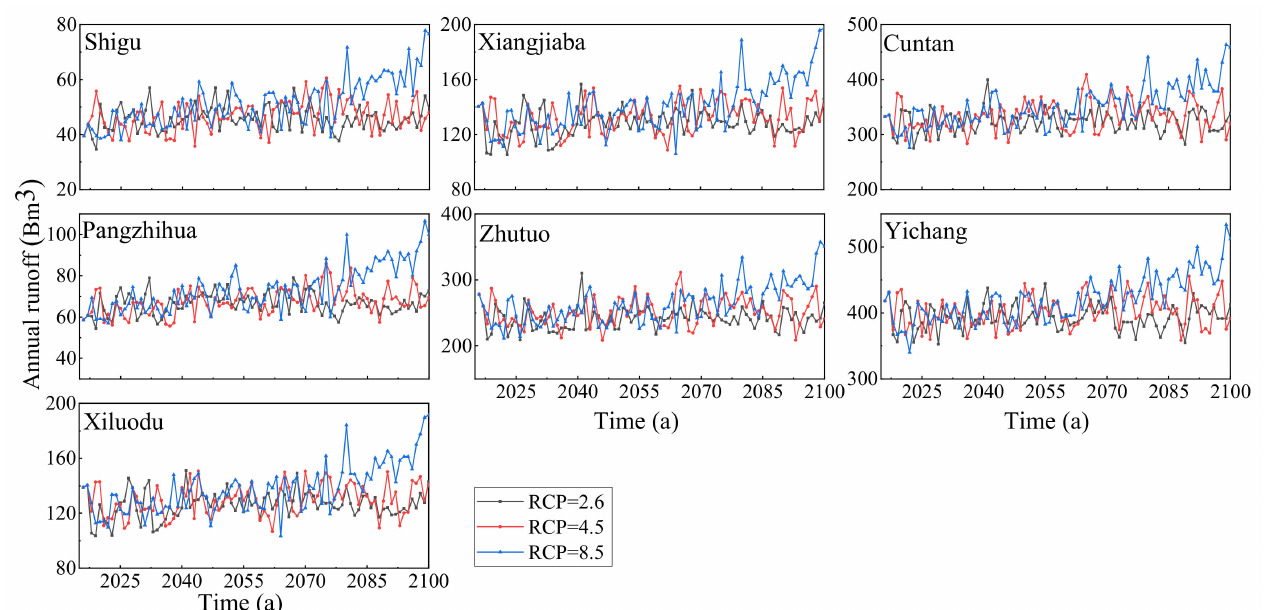
Figure 9. Predicted annual runoff under different emission scenarios for each section of the study area.